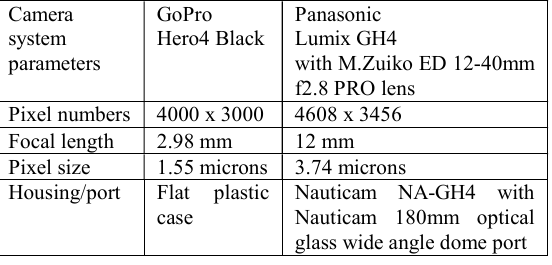
Table 1. Underwater cameras used in this study.